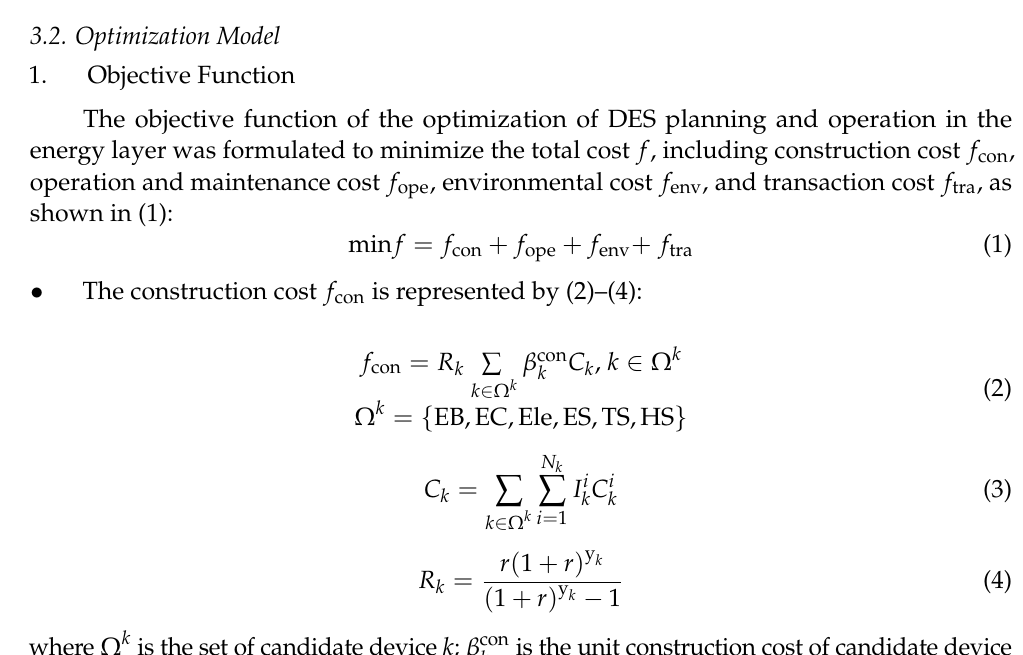
Figure 2. Example of DES system structure.